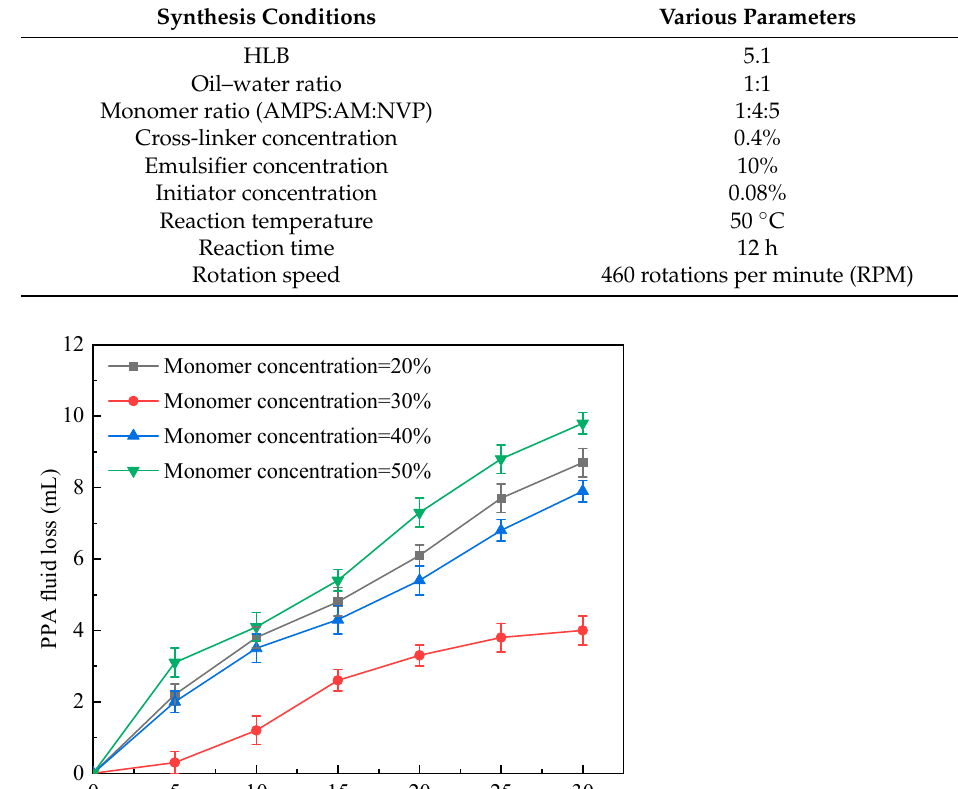
Table 4. The synthesis conditions of AMN other than total monomer concentration.